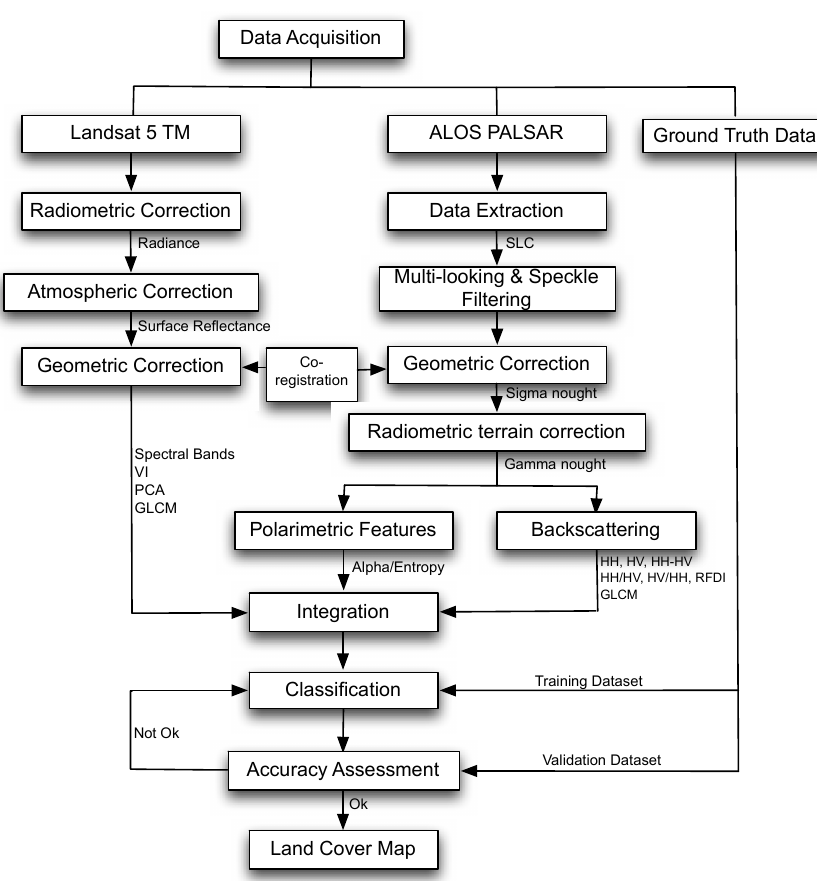
Figure 4. Flow chart of the utilized methodology.